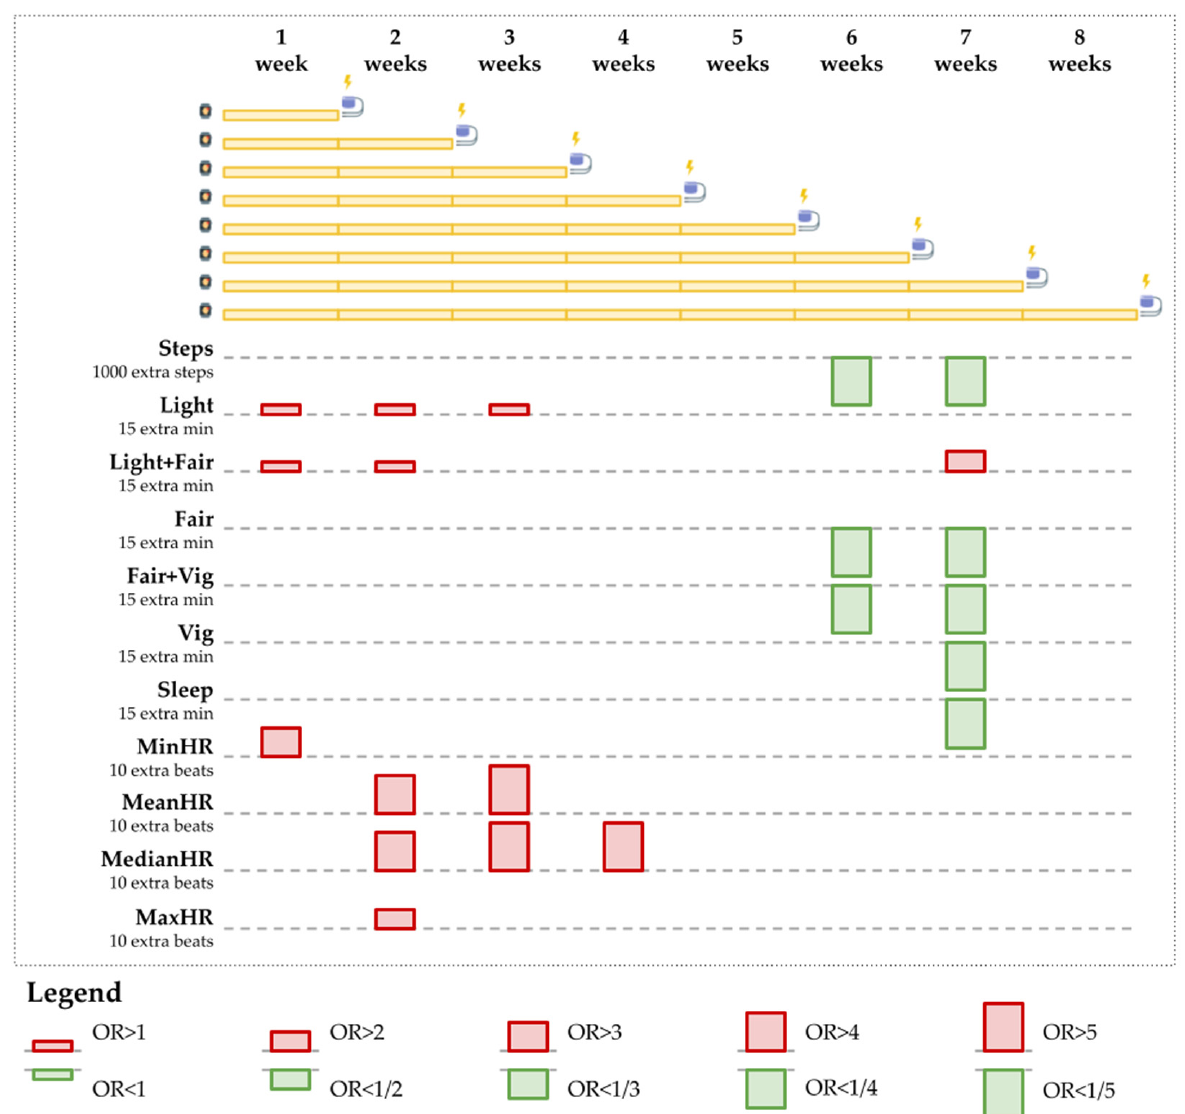
Figure 5. Odd ratios obtained from the separate models for 1000 extra steps, 15 extra minutes of physical activity or sleep, and 10 extra beats per minute for the heart rate. The separate Fitbit measurement periods of 1, 2, . . . 8 weeks are depicted on top. Below, informative estimations of the odd ratios are represented. For all results, p < 0.05. Periods in the separate models (depicted in yellow as sequences of weeks) are followed by potential events (depicted at the end of the yellow sequences). ORs are depicted as bars: OR > 1 (red and upwards) and OR < 1 (green and downward). Bar height corresponds to the distance between the OR and 1.